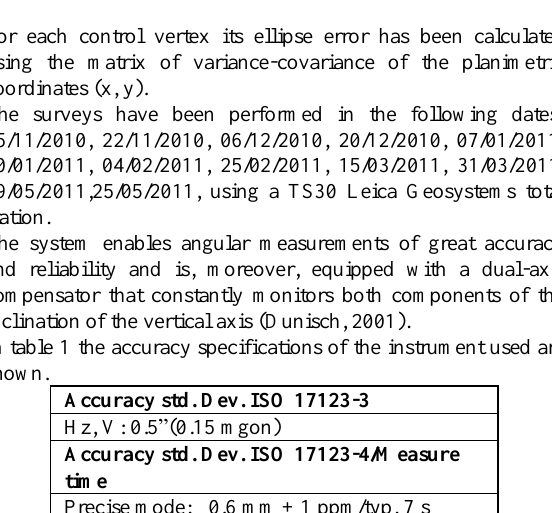
Figure 10. Triangulation schema